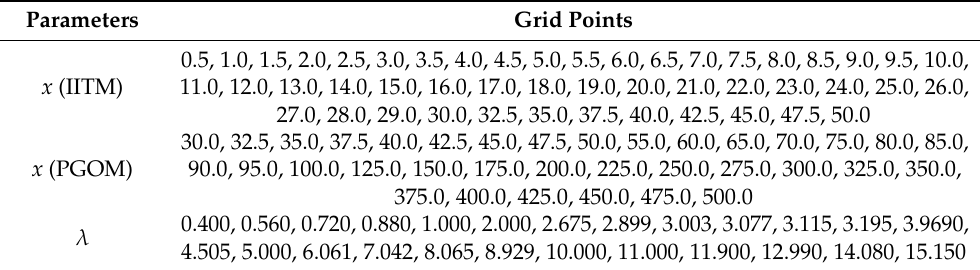
Table 1. Grid point values of database